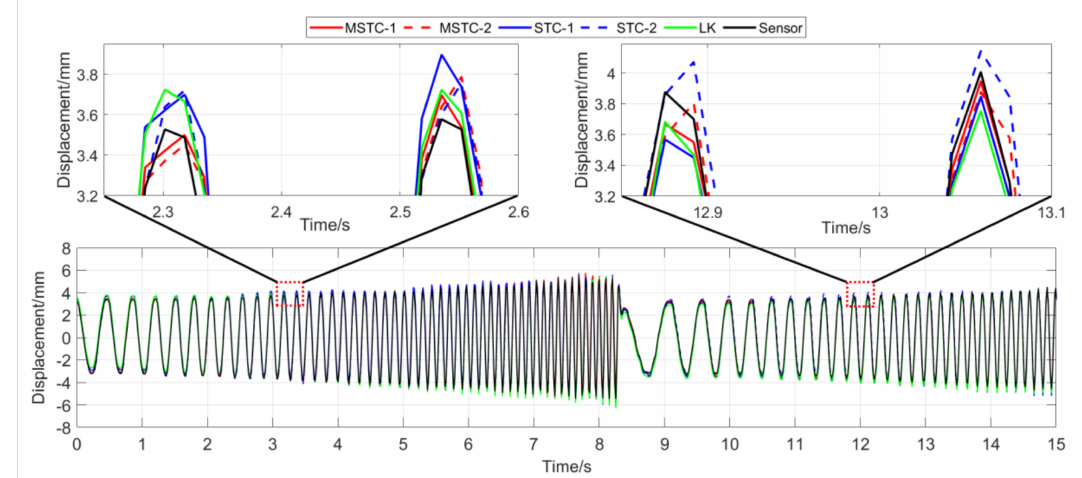
Figure 14. Displacement time history and local amplification in Scenario I (59.96 FPS).